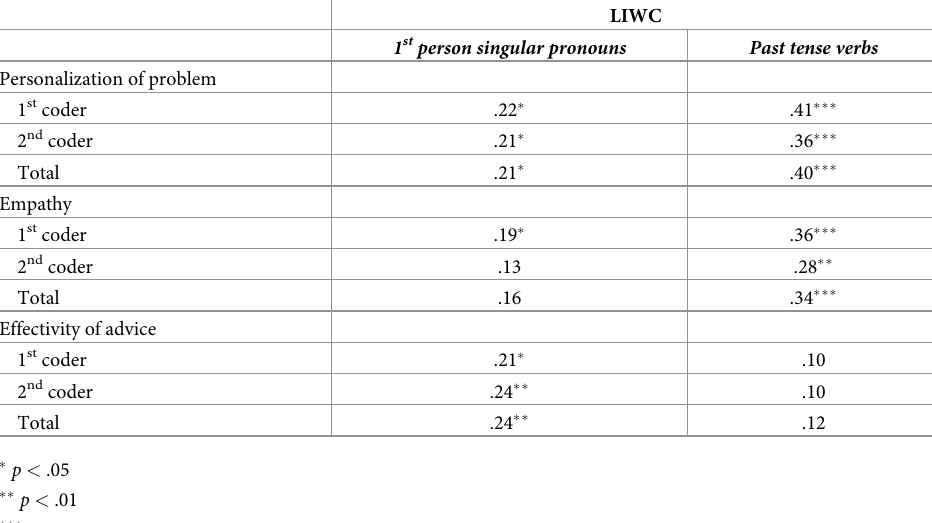
Table 10. Correlations between LIWC measures and the coders’ assessments on each scale in the emotional prob- lem-solving study–Spearman’s coefficient ( N = 120).